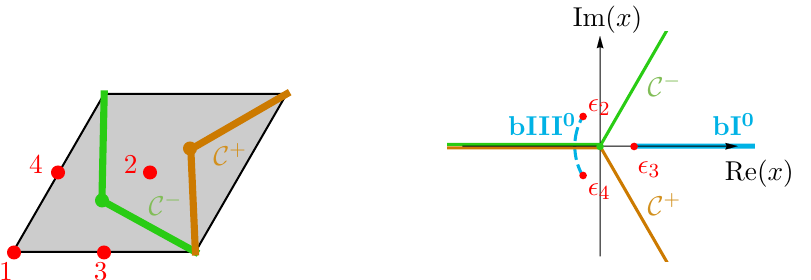
Figure 9 . Graphical representation of the union cycles C (cid:0) = bII 0 [ bII (cid:0) and C + = bII 0 [ bII + on a hexagonal torus lattice (left) and on an elliptic curve embedded in P 112 (right). The cycles C (cid:0) and C + are drawn in the x -plane ( v = 1) by virtue of Weierstrass’ elliptic function.